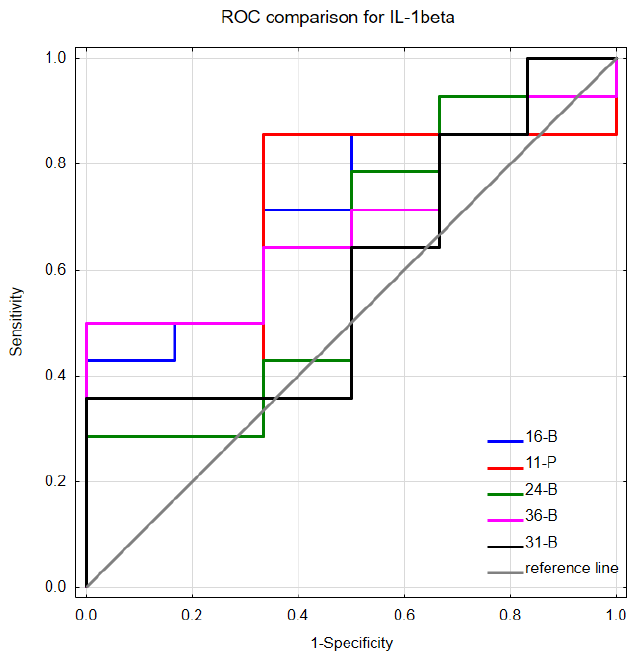
Figure 5. ROC curves for interleukin-1 β concentration (B, buccal/labial; P, palatal/lingual). The most representative gingival crevice that accurately classified bruxists based on Table 5. Results of ROC analysis for interleukin- 1β concentration. the volume of gingival crevicular fluid secreted seemed to be the crevice near the buccal surface of tooth 36. In contrast, based on IL-1 β concentration in GCF, the crevice near the buccal surface of tooth 16 may have the best predictive power, as indicated by the largest AUC in the ROC analysis (close to the statistical significance